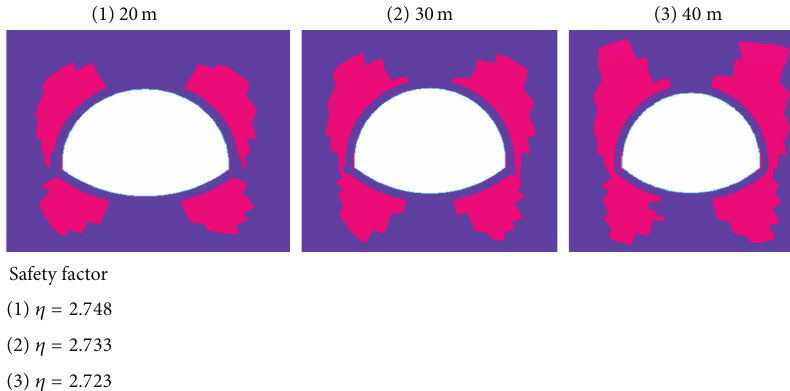
Figure 3: Plastic zones and safety factors with different water depths.